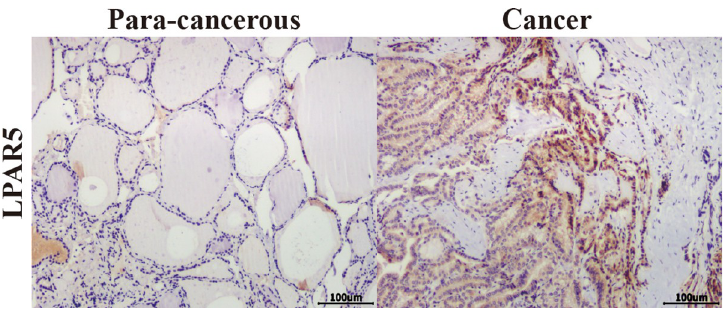
Fig 8. Representative IHC for LPAR5 expression in tissue microarrays (scale bar, 100 μ m). The categories of the expression of LAPR5 immunostaining in the papillary thyroid carcinoma at 100 × magnification. Left: para-cancerous tissue; right: cross-section of a tumor obtained from PTC patient shows intense cytoplasmic staining.